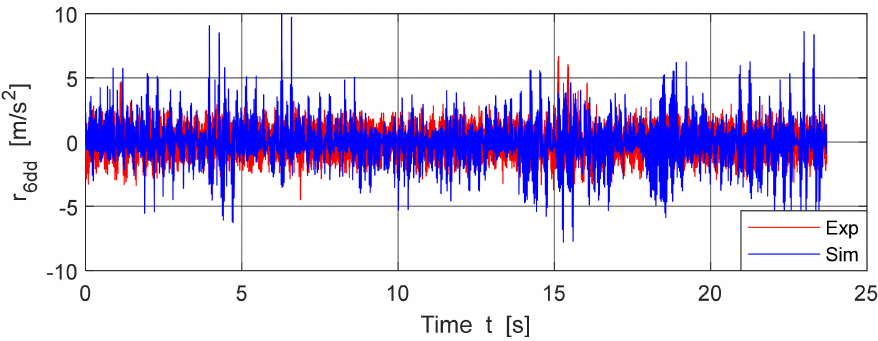
Figure 24. Acceleration on right rear axle, V = 15.18 km/h.